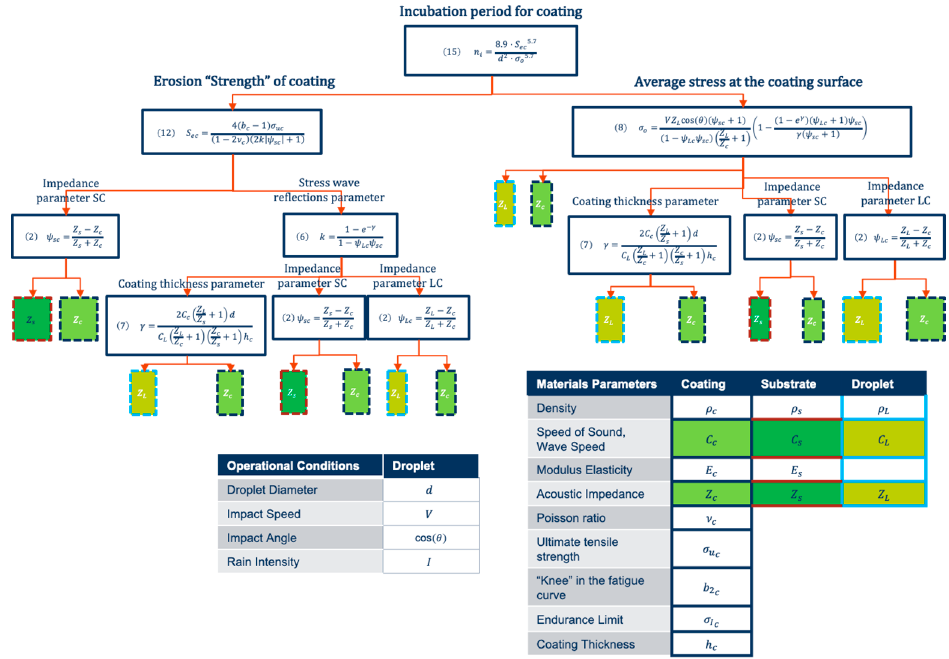
Figure 8. Diagram of liquid, coating and substrate material impedances and operational parameters affecting rain erosion performance.